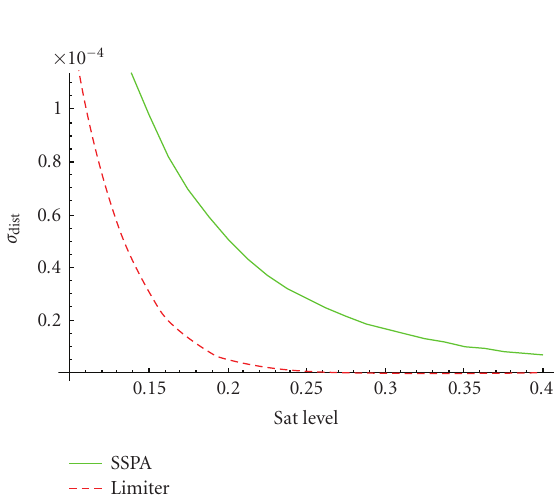
Figure 6: NLA distortion versus saturation level a , with s = 0 .